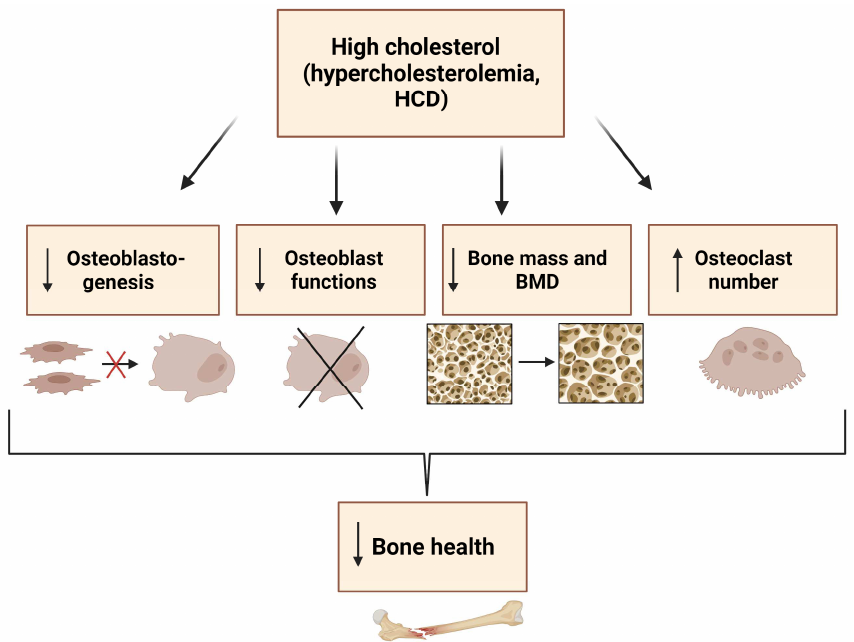
Figure 4. Summary of the effects of cholesterol on osteoblasts. A high cholesterol diet (HCD) and hypercholesterolemia have negative effects on bone health. They manifest as reduced proliferation and differentiation of bone marrow stromal cells, which in turn results in decreased osteoblastogenesis. Such a hyperlipidemic condition affects several aspects of osteoblast function and homeostasis, increases the number and activity of osteoclasts, and decreases bone mass and bone mineral density (BMD). This figure was created using Biorender.com (accessed on 13 March